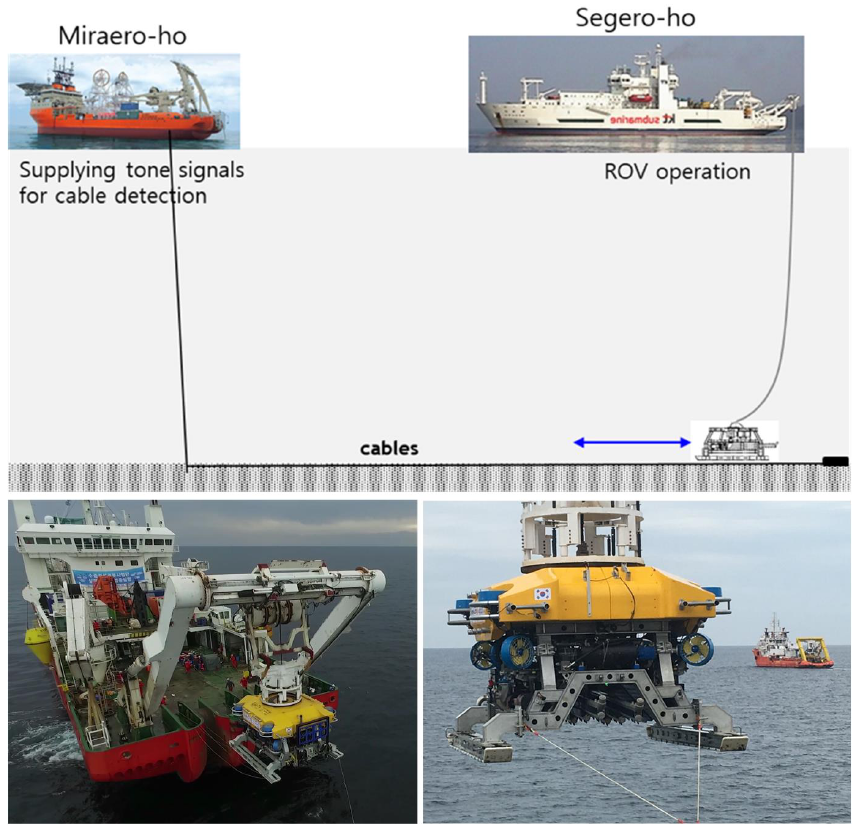
Figure 13. East Sea trial in October 2018.